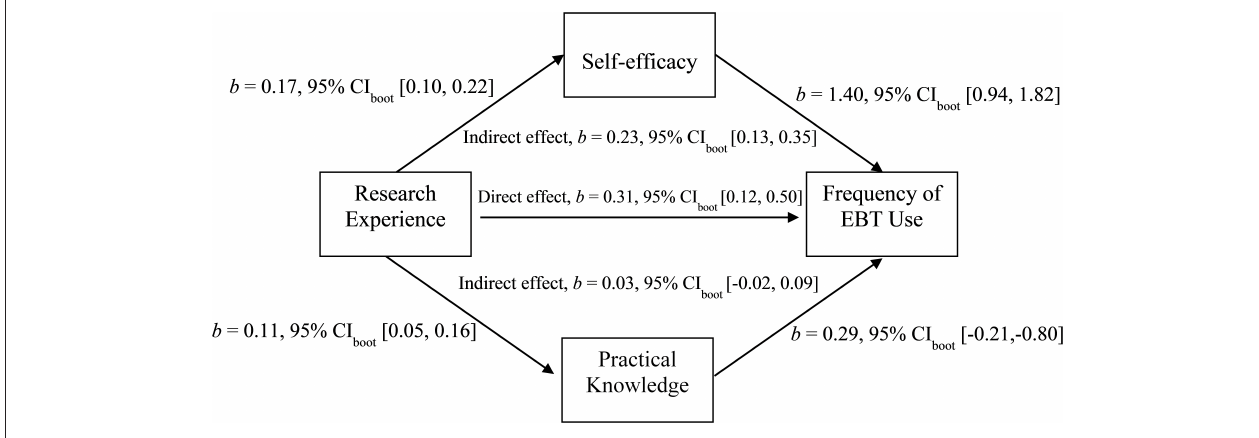
FIGURE 3 | Full mediation model including both mediators. Unstandardized values reported.